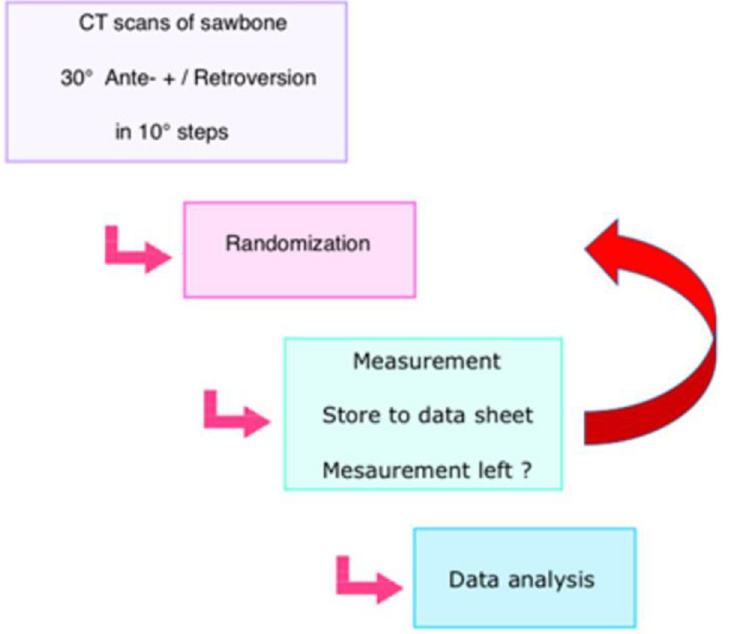
Fig 2. Workflow. The roadmap of the validation study is